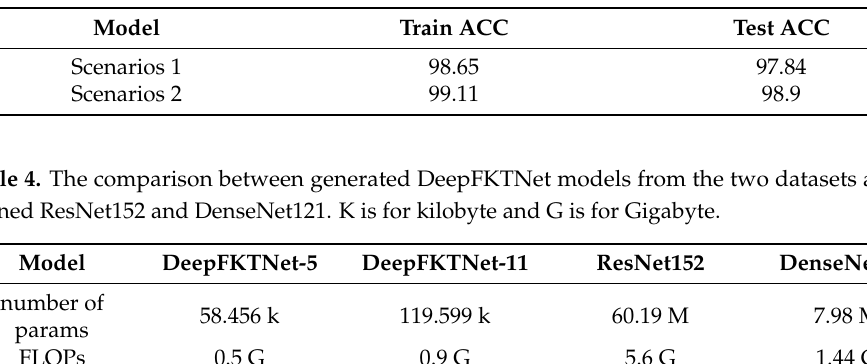
Table 3. The train and test accuracy of DeepFKTNet-11 models for two scenarios.